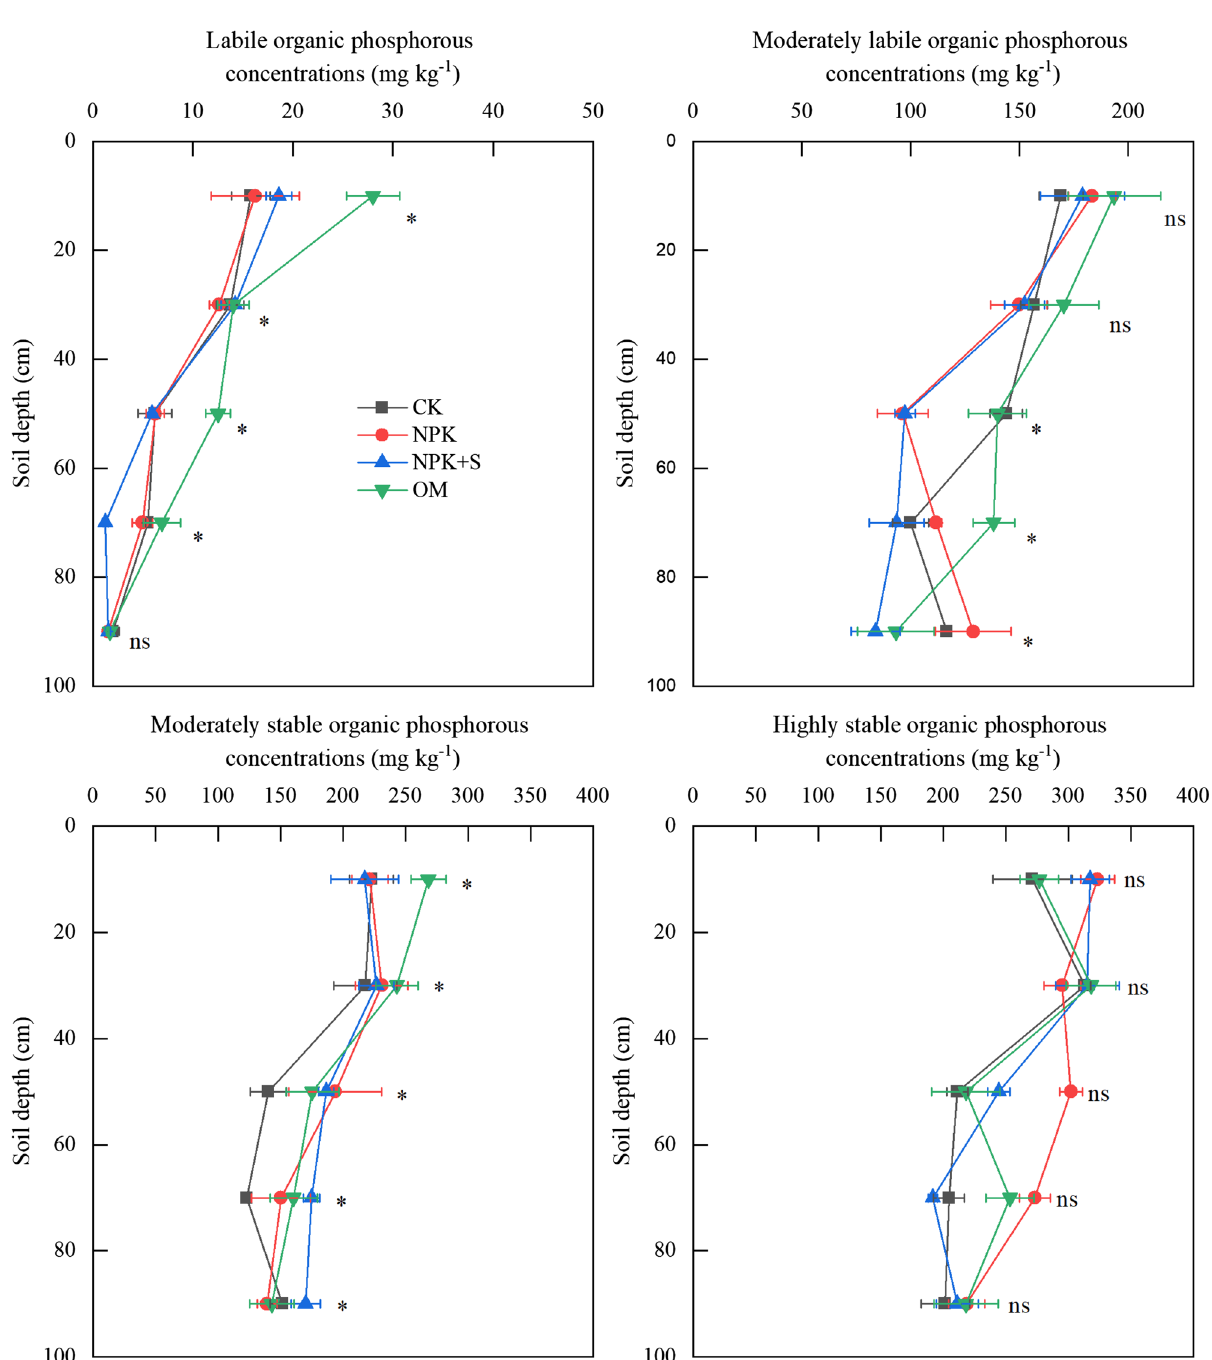
Figure 6. Effect of long-term application of chemical fertilizer, organic manure and straw on the distribution of organic P fractions. * indicates significant difference at P < 0.05 level at the same soil depth, ns indicates no significant difference regarding labile organic P, moderately labile organic P, moderately stable organic P and highly stable organic P concentrations at the same soil depth. CK, no fertilizer application; NPK, chemical fertilizer application; NPK + S, chemical fertilizer plus maize straw incorporation; OM, organic manure of total P associated under NPK and NPK + S treatments increased by 1.0–4.0 percentage. The greatest variations among these fractions were observed at the 0–20 cm soil depth. However, OM treatment did not impact the proportion of different Po fractions of the total P compared with CK treatment. Field treatments did not impact the proportion of different P fractions of the total P below 40 cm soil depths.